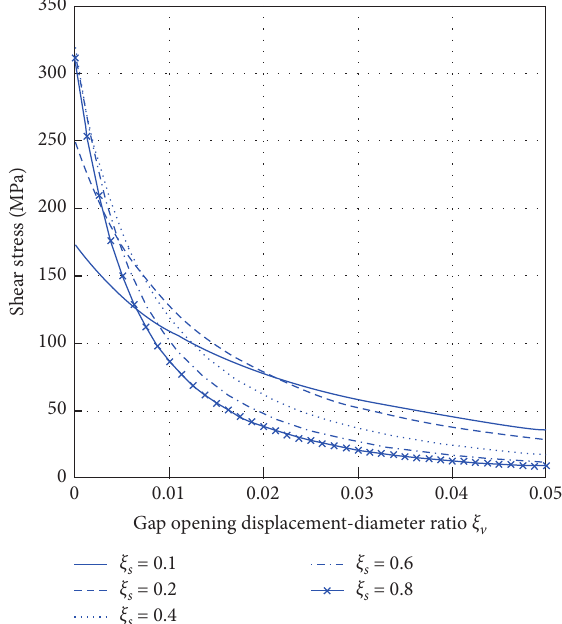
Figure 2: The curve of ξ v against shear stress of single steel bar with different ξ s . ξ s is the interface slip-diameter ratio; ξ v is the vertical gap opening displacement-diameter